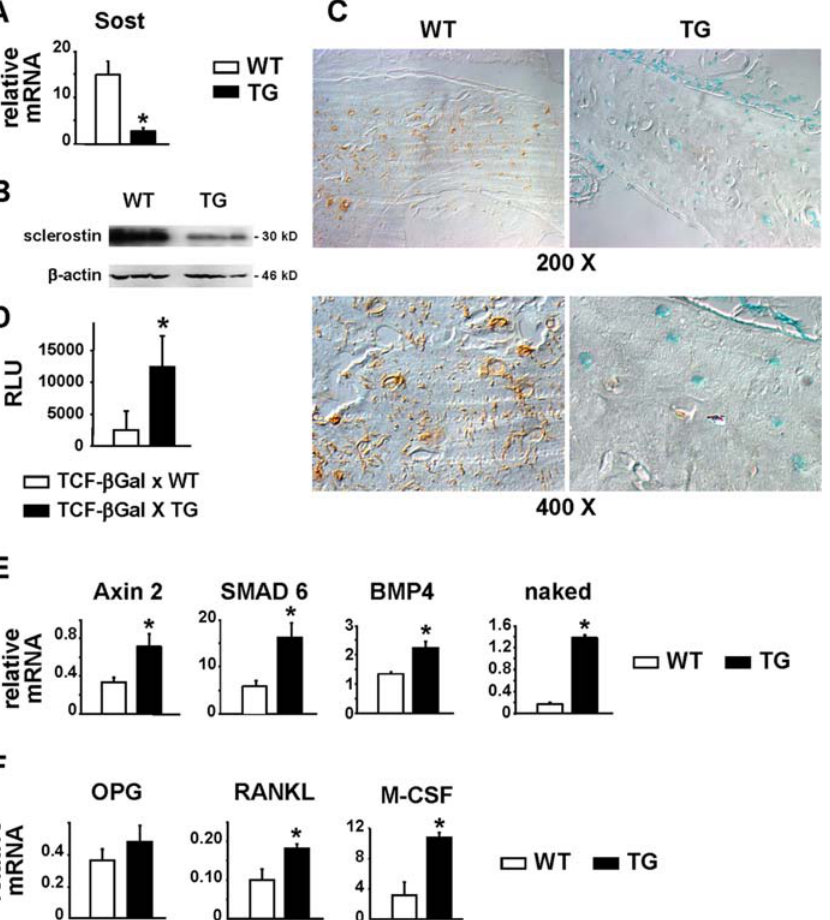
Figure 4. Sost and Sclerostin Expression are Decreased and Wnt Signaling is Increased in DMP1-caPTHR1 Transgenic Mice. (A) Quantitative RT-PCR analysis of Sost mRNA in tibia from 9-week-old DMP1-caPTHR1 mice and wild type littermates (n=3). Both sexes were included. (B) Sclerostin protein levels were determined by Western blot analysis of lysates from the 6th lumbar vertebrae of 9-week-old wild type (WT) and DMP1-caPTHR1 (TG) mice. Each lane contains protein lysate from a single mouse. (C) Anti-sclerostin immunohistochemistry in ulnae sections from 10.5-week-old WT and TG mice. (D) b -galactosidase activity was measured in lysates of femurs obtained from 4.5-week-old TCF- b gal reporter mice with and without the DMP1-caPTHR1 transgene, and is expressed as relative luminescence units (RLU)/200 mg protein (n=3–5 mice/group). Quantitative RT-PCR analysis of the indicated Wnt target genes (E) , and OPG, RANKL, and M-CSF (F) , in tibia from 8-week-old DMP1-caPTHR1 mice and wild type littermates. Bars represent the mean 6 SD of 3 mice. * p , 0.05 vs. WT